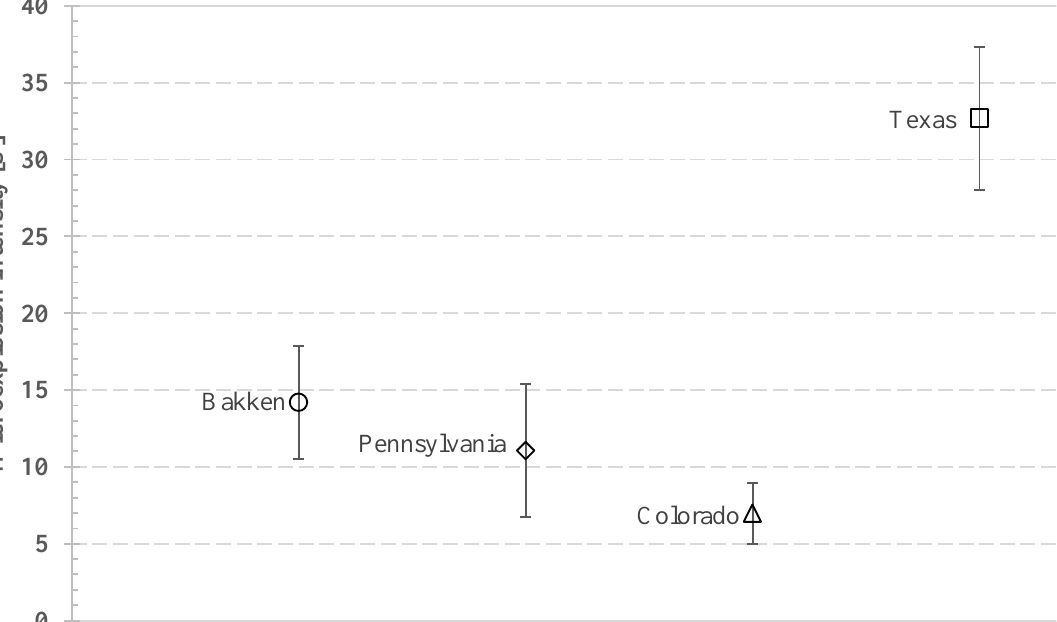
Figure 11. The average microexplosion intensity for various crude oils in Zone III.